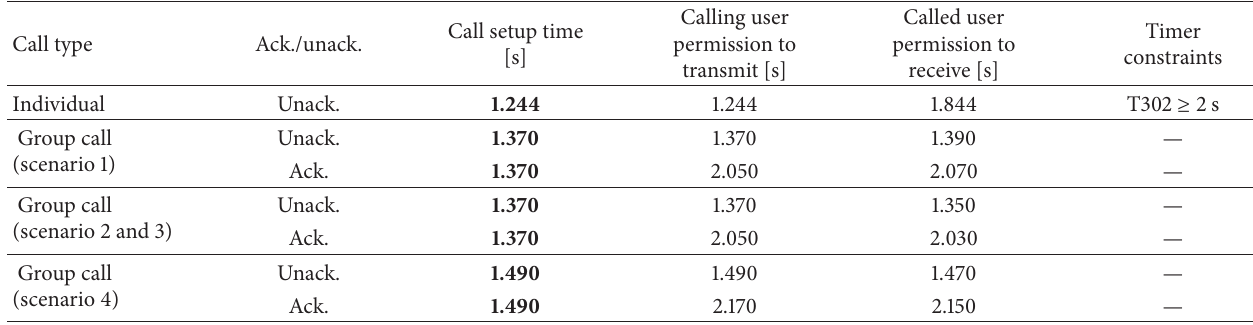
Table 3: TETRA call setup times with A-bis via